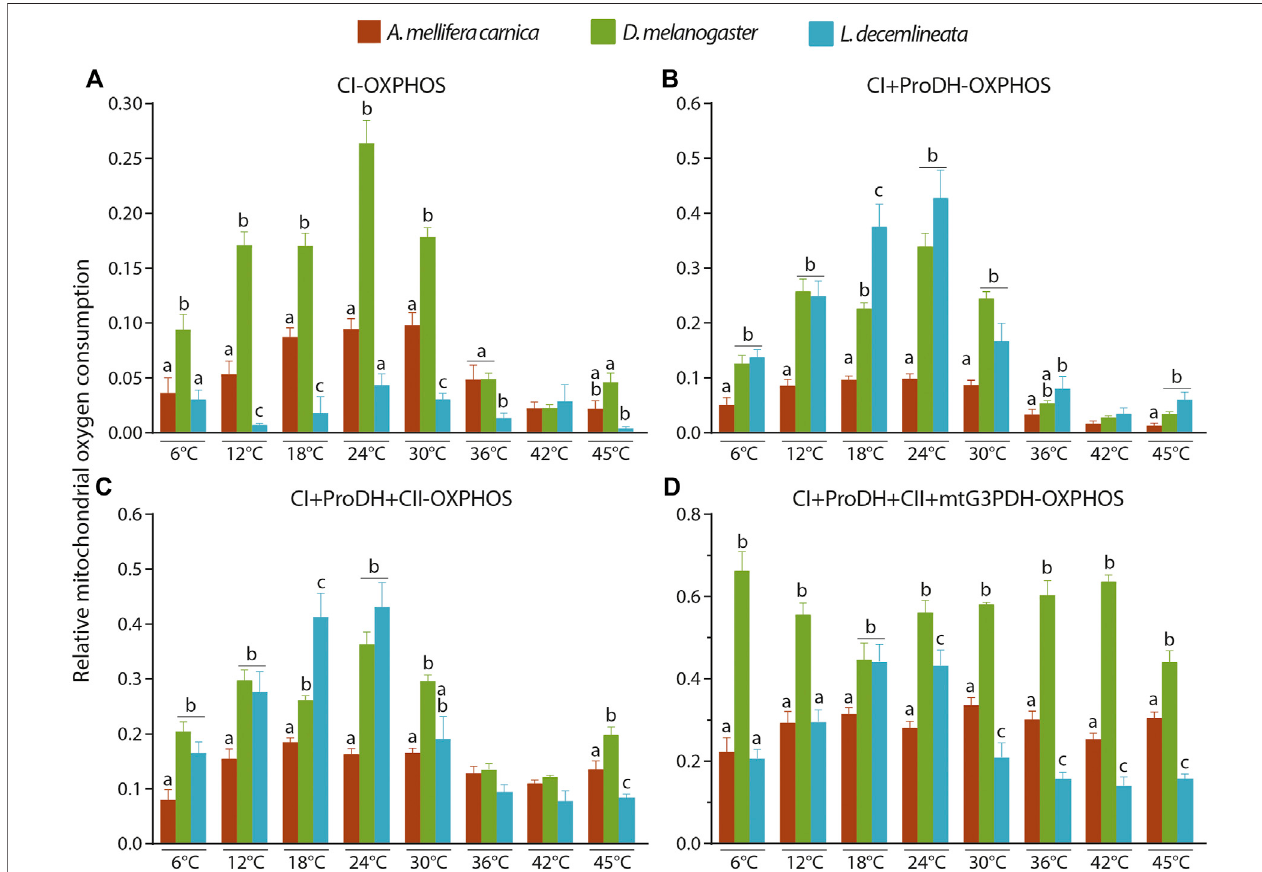
FIGURE 5 | Interspecies comparisons of relative OCRs in the permeabilized thoraces of the three insect species ( A. mellifera carnica , D. melanogaster , and L. decemlineata ). (A) CI-OXPHOS, (B) CI+ProDH-OXPHOS, (C) CI+ProDH+CII-OXPHOS,and (D) CI+ProDH+CII+mtG3PDH-OXPHOS.RelativeOCRsarereported asmean±s.e.mandwereobtainedbydividingeachOCRbythecorrespondingcomplexIVmaximalOCRfor6( n =6 – 10),12( n =6 – 10),18( n =5 – 10),24( n =5 – 10),30 ( n = 6 – 10), 36 ( n = 6 – 10), 42 ( n = 6 – 10) and 45 ° C ( n = 5 – 9). Relative OCRs were compared between species for each assay temperature using a one-way ANOVA followed by a HSD (Honest Signi fi cant Difference) Tukey ’ s test. Dissimilar letters indicate signi fi cant differences between species at each assay temperature. For CI + ProDH + CII-OXPHOS at 30 ° C, one-way ANOVA conditions were not met, and a non-parametric test (Kruskall-Wallis) followed by a Dunn ’ s test were